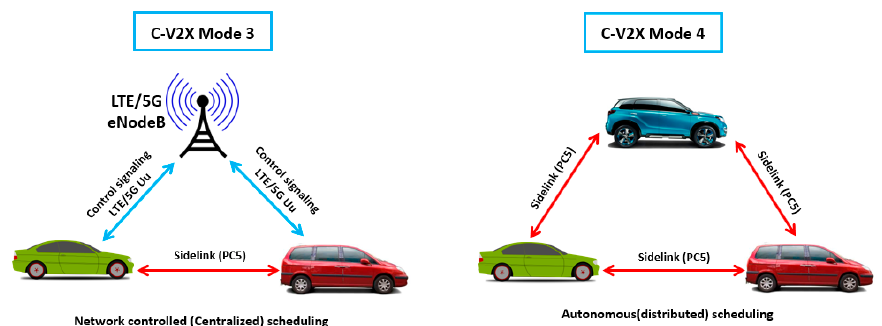
Figure 2. Illustration of scheduling modes for C-V2X communication system.